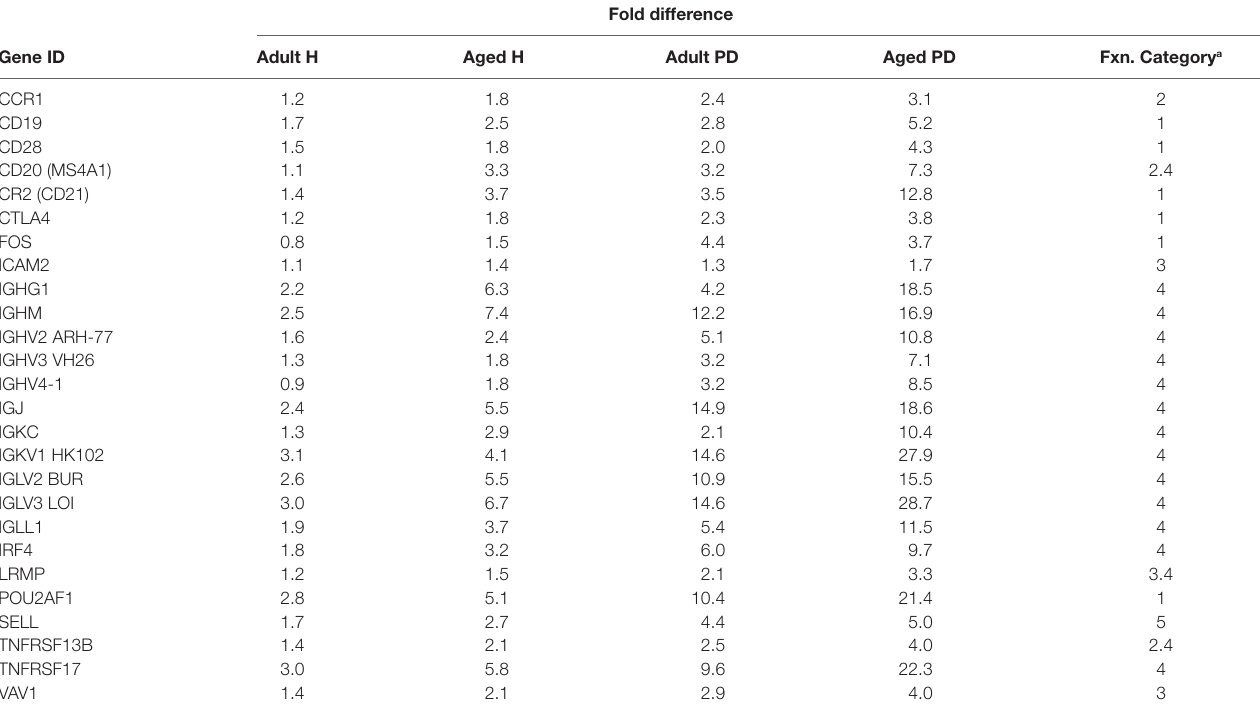
a Functional categories denoted as 1 – antigen-dependent activation; 2 – cell activation; 3 – cell proliferation; 4 – differentiation/maturation; 5 – plasmacyte; 6 – multiple functions.